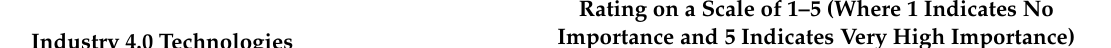
Table 2. Importance of individual Industry 4.0 technologies for business models. Rating on a Scale of 1–5 (Where 1 Indicates No Importance and 5 Indicates Very High Industry 4.0 Technologies